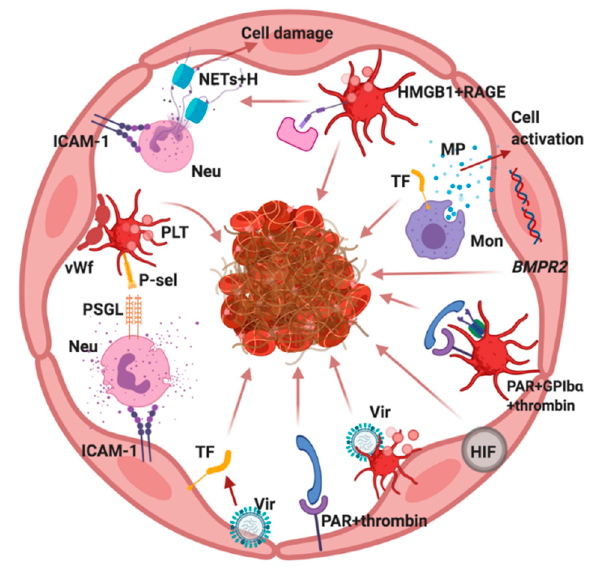
Figure 2. Possible mechanisms of pulmonary artery (PA) thrombosis.